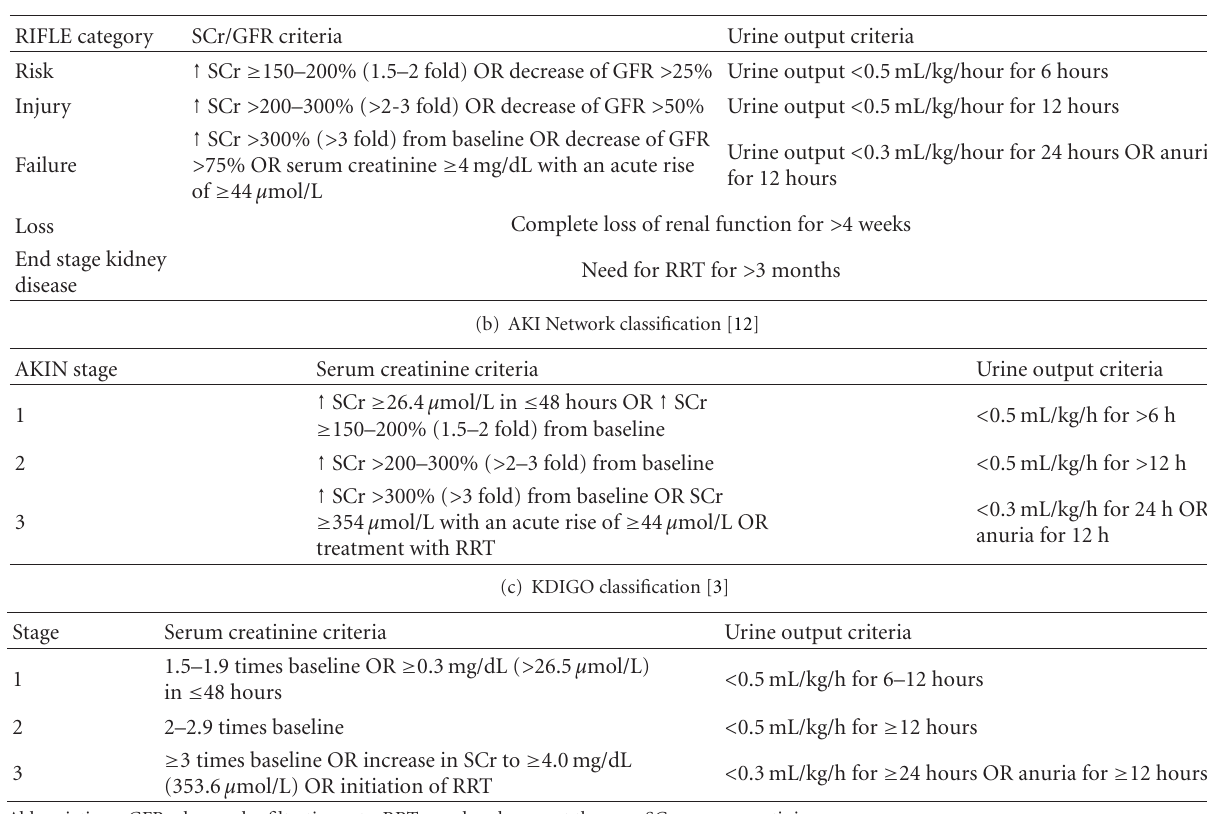
Table 1: Classifications to define